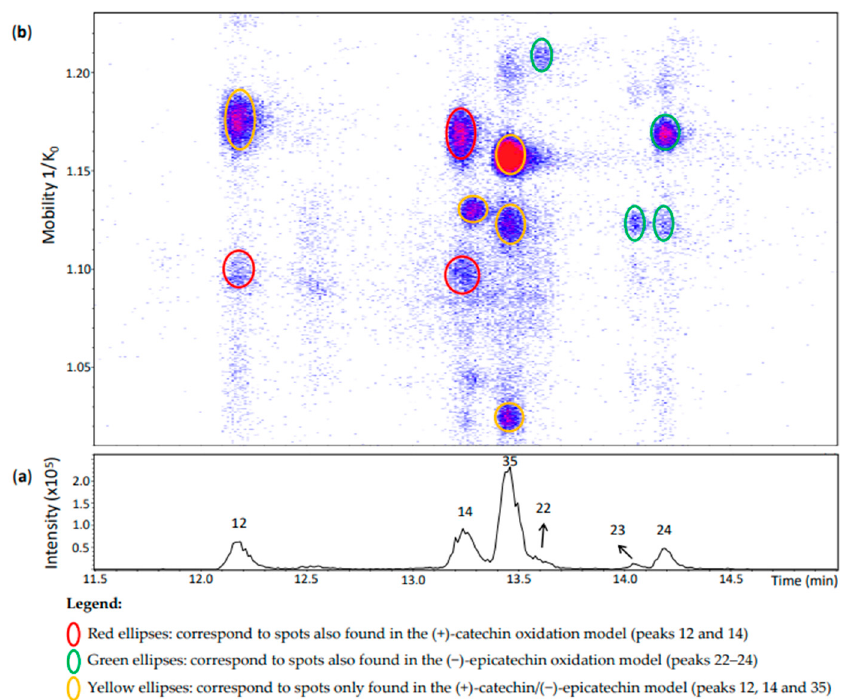
Figure 6. UHPLC − ESI ( − ) − TIMS − QTOF − MS/MS analysis of dehydrodicatechins in model solution containing (+)-catechin and ( − )-epicatechin along with a grape PPO extract. ( a ) EIC from the mass range of m / z 577.1–577.2; ( b ) heat map showing the mobility versus Rt for the mass range of m / z 577.1–577.2. Full details on peak numbers are available in Table S2. * Signal of isotopic ion at m / z 577 of m / z 575 that is found in Figure 7 (peaks 14, 35 and 24). Ellipses on the heat map mark the main spots.